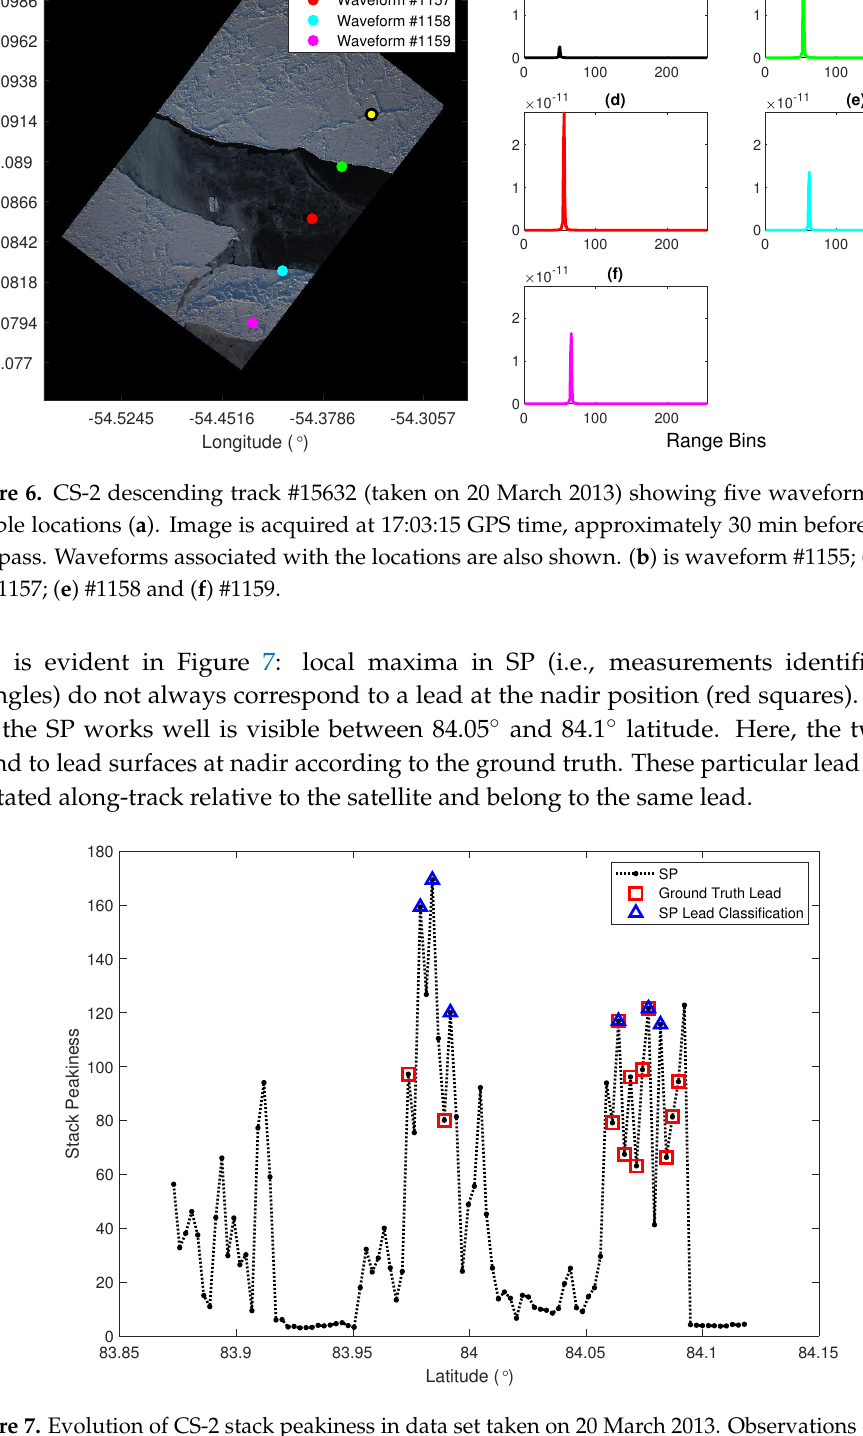
Figure 7. Evolution of CS-2 stack peakiness in data set taken on 20 March 2013. Observations classified as leads by the STACK classifier are marked in blue. Actual nadir leads identified by the ground truth are highlighted in